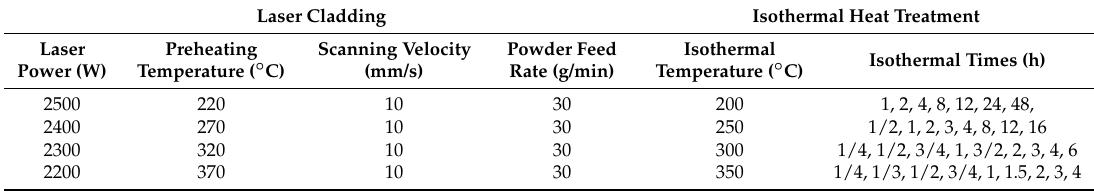
Table 1. Processing parameters for laser cladding and isothermal